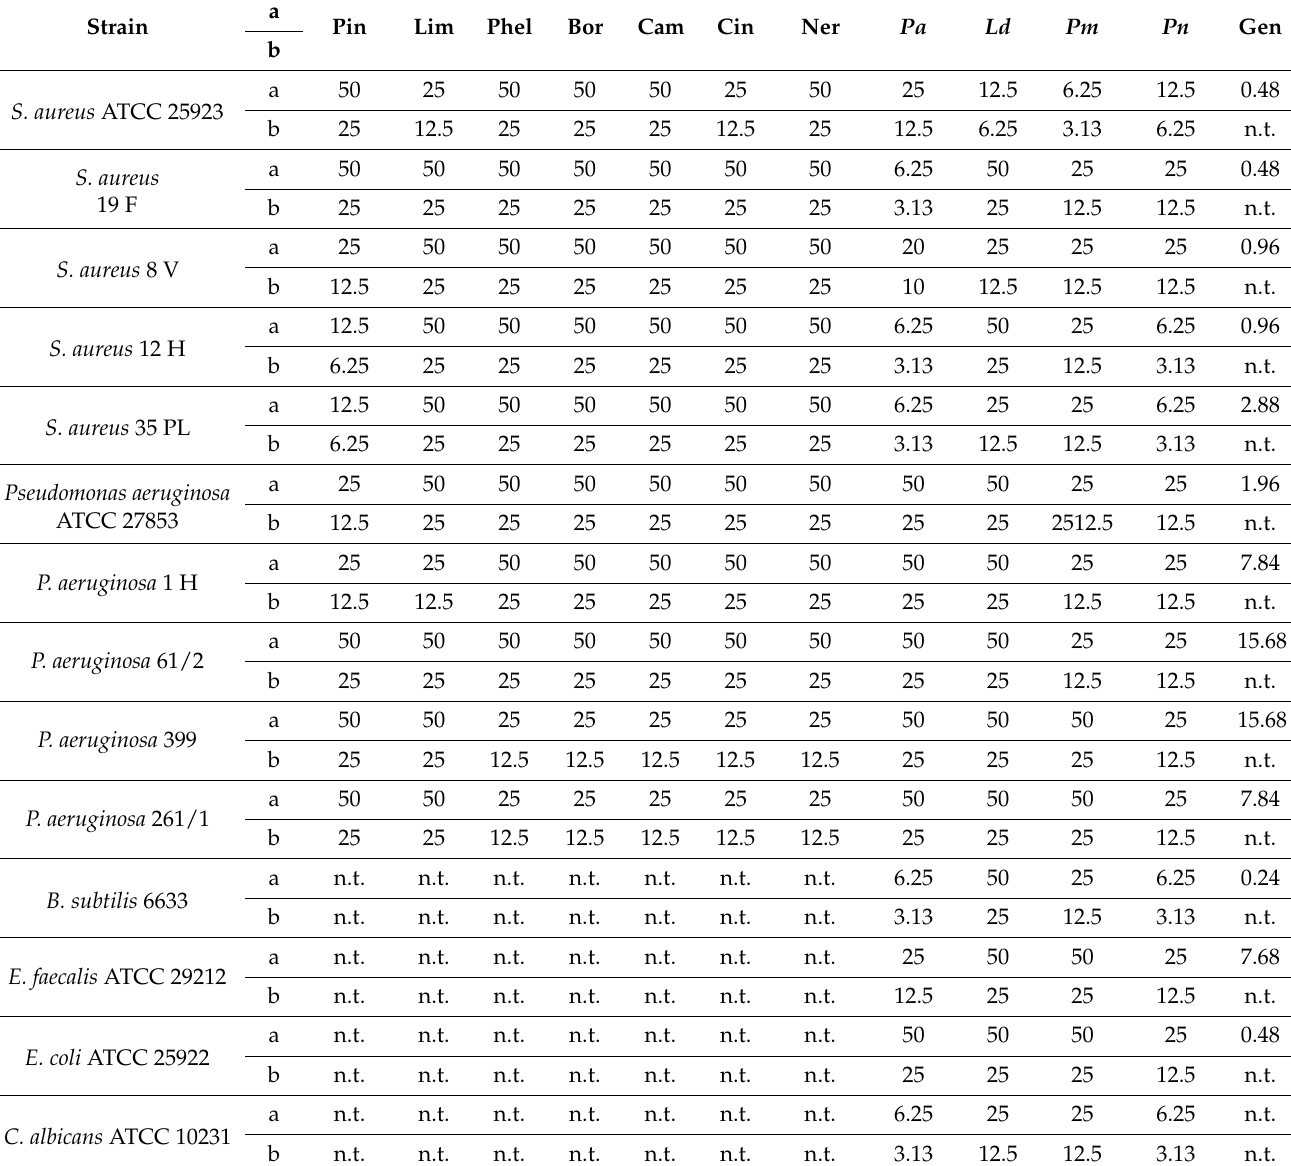
Table 2. The MIC ( µ L/mL) a and MBEC ( µ L/mL) b values for P. abies , L. decidua , P. menziesii and P. nigra essential oils and for some pure compounds against Gram-positive bacteria, Gram-negative bacteria and C. albicans .